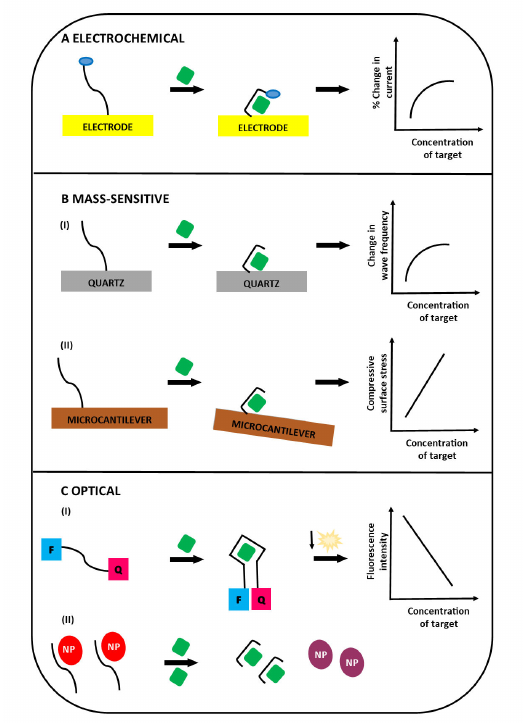
Figure 2. Examples of electrochemical, mass-sensitive and optical aptamer biosensors. A —The aptamer is attachedtoanelectrodeatoneendwithanelectrochemicalreporter(blueoval)covalentlylinkedtotheother end. Bindingoftheaptamertoitstargetligand(greenrectangle)resultsinachangeinitsshape,